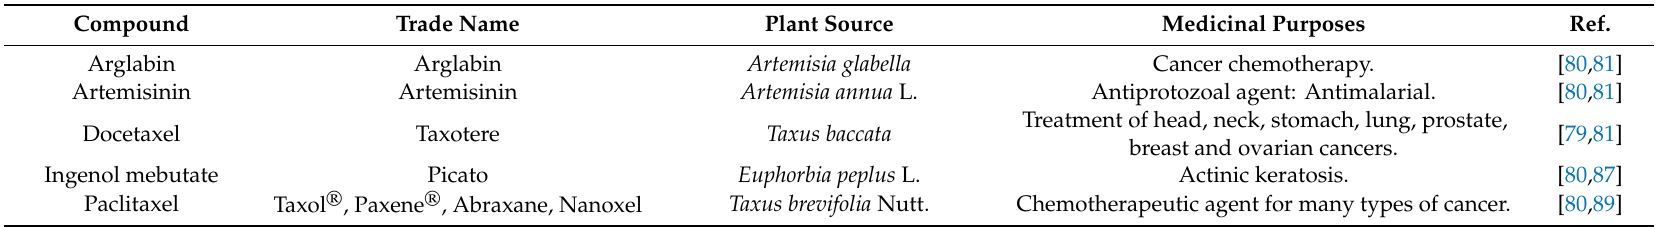
Table 2. Plant-derived terpenes approved for therapeutic use. Additional resources from https: // www.drugs.com / and https: // www.drugbank.ca